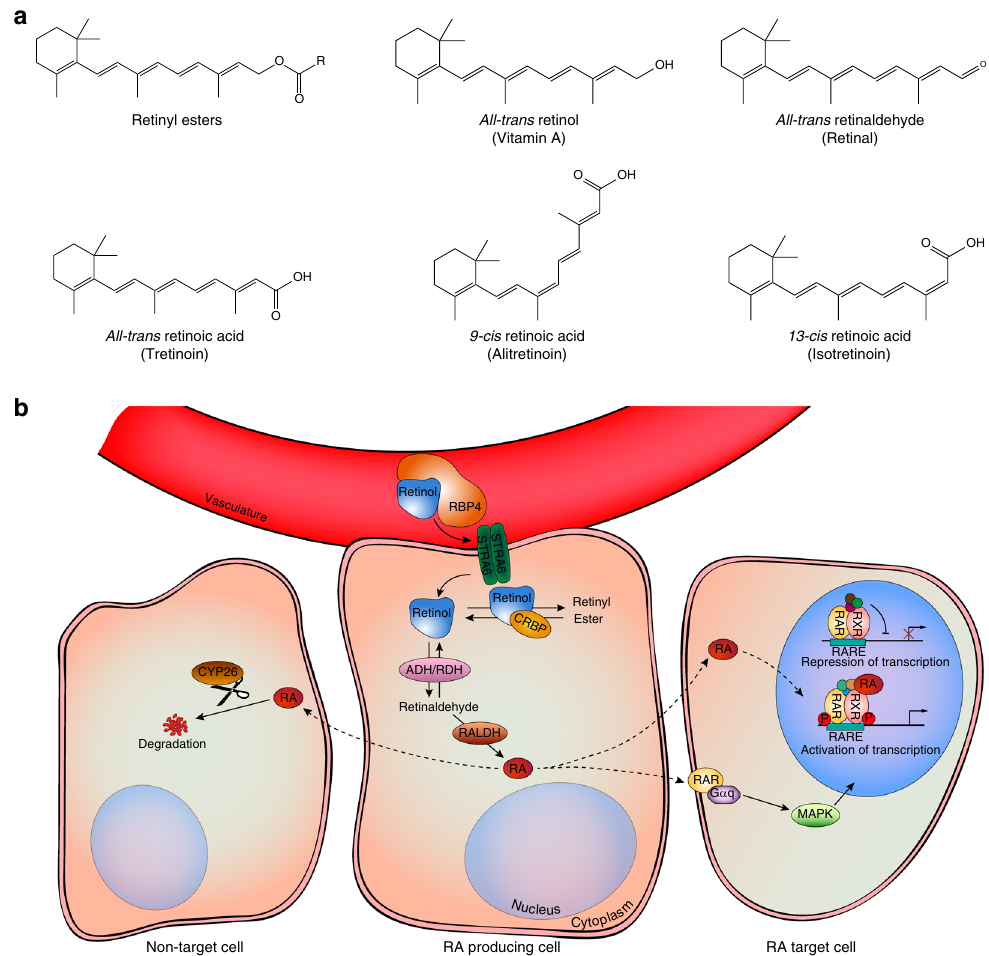
Fig. 2 Retinoid chemical structures ( a ) and RA signaling pathway ( b ). Blood-circulating retinol is internalized through membrane transporter and receptor stimulated by retinoic acid 6 (STRA6) and converted into all- trans retinoic acid (RA), which binds to cellular retinoic acid-binding protein type 2 for signaling in the nucleus. RA triggers gene transcription by binding to RA receptors (RAR) and to the retinoid X receptor (RXR). In the presence of the ligand, RAR and RXR heterodimerize on retinoic acid-response element (RARE) sequences located in promoter regions inducing the transcription of target genes. Of note, RXR may also homodimerize and trigger gene transcription (not depicted in the illustration). RA signaling may also occur via activation of receptors associated with lipid rafts located on the cell surface, which trigger transcriptional activation of target genes by histone and receptor phosphorylation in the cell nucleus. ADH alcohol dehydrogenase, CRBP cellular retinol-binding protein 1, CYP26 cytochrome P450 family 26, G α q Gq protein alpha subunit, MAPK mitogen activated protein kinases, P phosphorylation, RALDH retinaldehyde dehydrogenase, RBP4 retinol-binding protein 4, RDH retinol